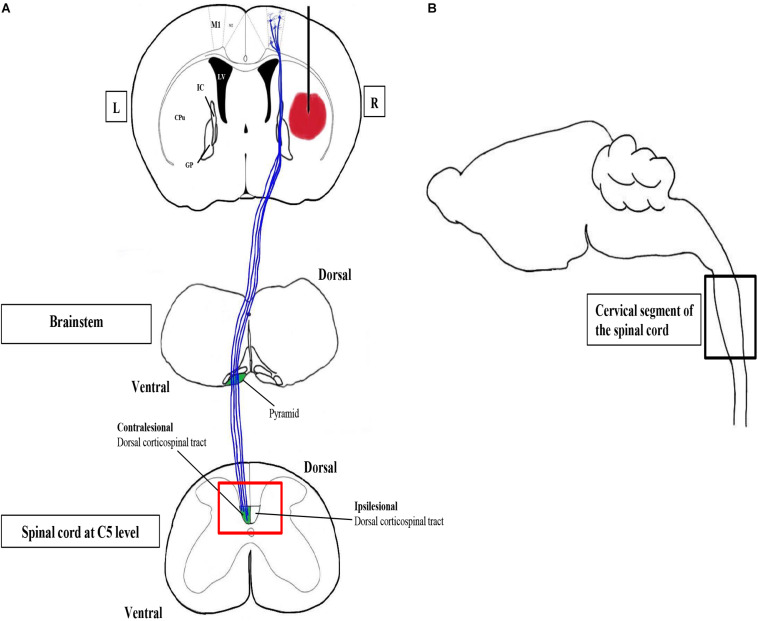
Confocal and transmission electron microscopy to study CST changes after ICH. The corticospinal tract (CST) is the major system for skilled voluntary movement in human and motor functions in rodents. Motor recovery after stroke critically depends on CST integrity. The CST is the only descending pathway in which some axons form synapses with spinal motor neurons directly. M1 is the primary motor cortex containing pyramidal neurons, the axons of which constitute the CST. The CST, which is highlighted in blue, passes through the internal capsule (IC) to the pyramids of the brainstem, where the majority of CST fibers decussate to the contralateral side. (A) A simplified coronal section of the brain with the hematoma in the right striatum, together with schematic diagrams of the horizontal sections of the brainstem and the spinal cord, respectively. The red box is the region of interest, the CST zone at C5 level, of our study. L, left; R, right. (B) A simplified parasagittal section of the brain and spinal cord.